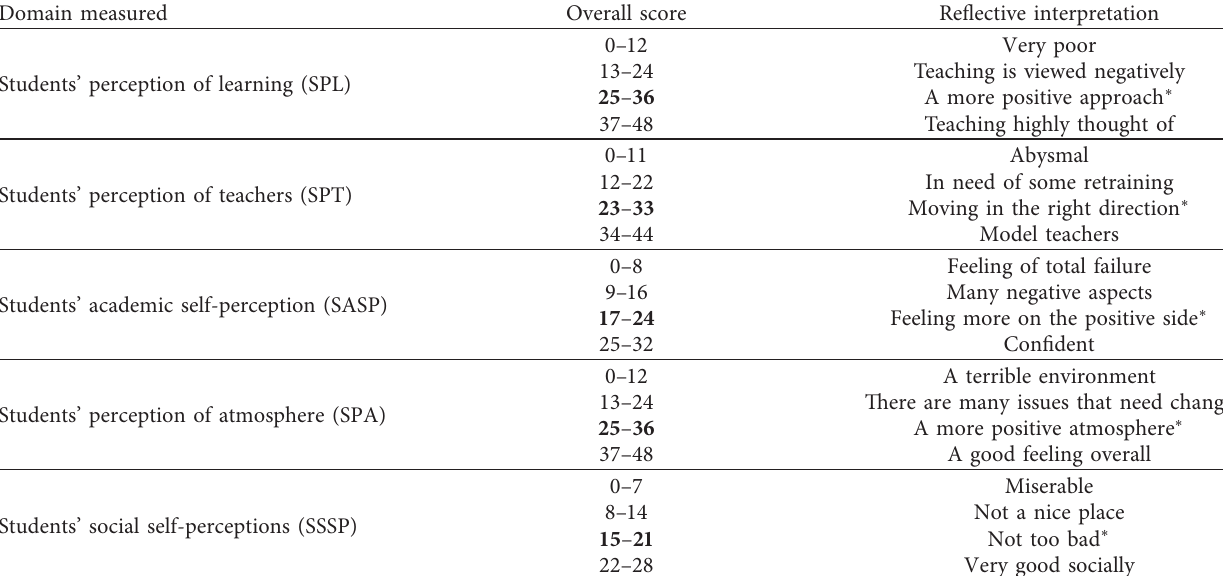
Table 2: Guide of DREEM score categories and interpretation according to domain.